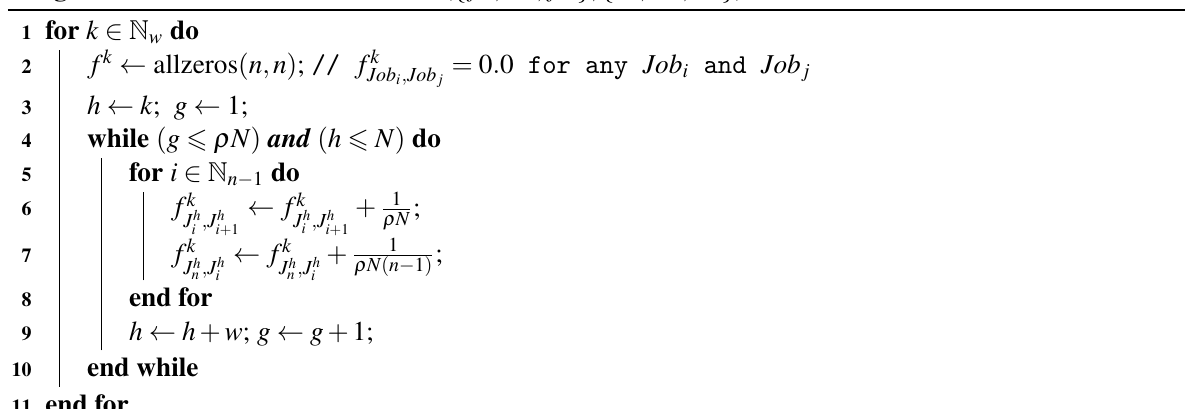
Algorithm 5: Method U PDATE PMF S ( { f 1 ;:::; f w } ; { J 1 ;:::; J N }